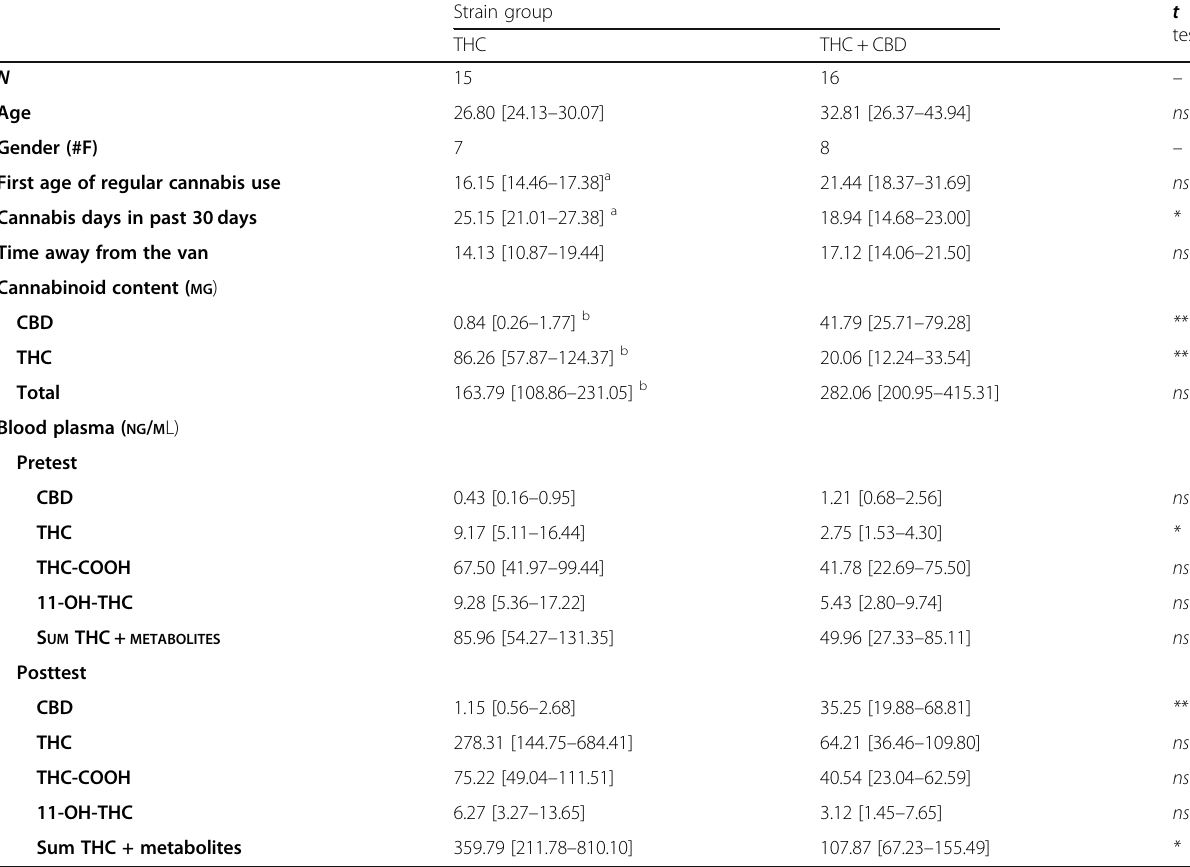
Table 2 Participant characteristics and blood biomarkers by strain group. Means are reported with 95% confidence intervals in